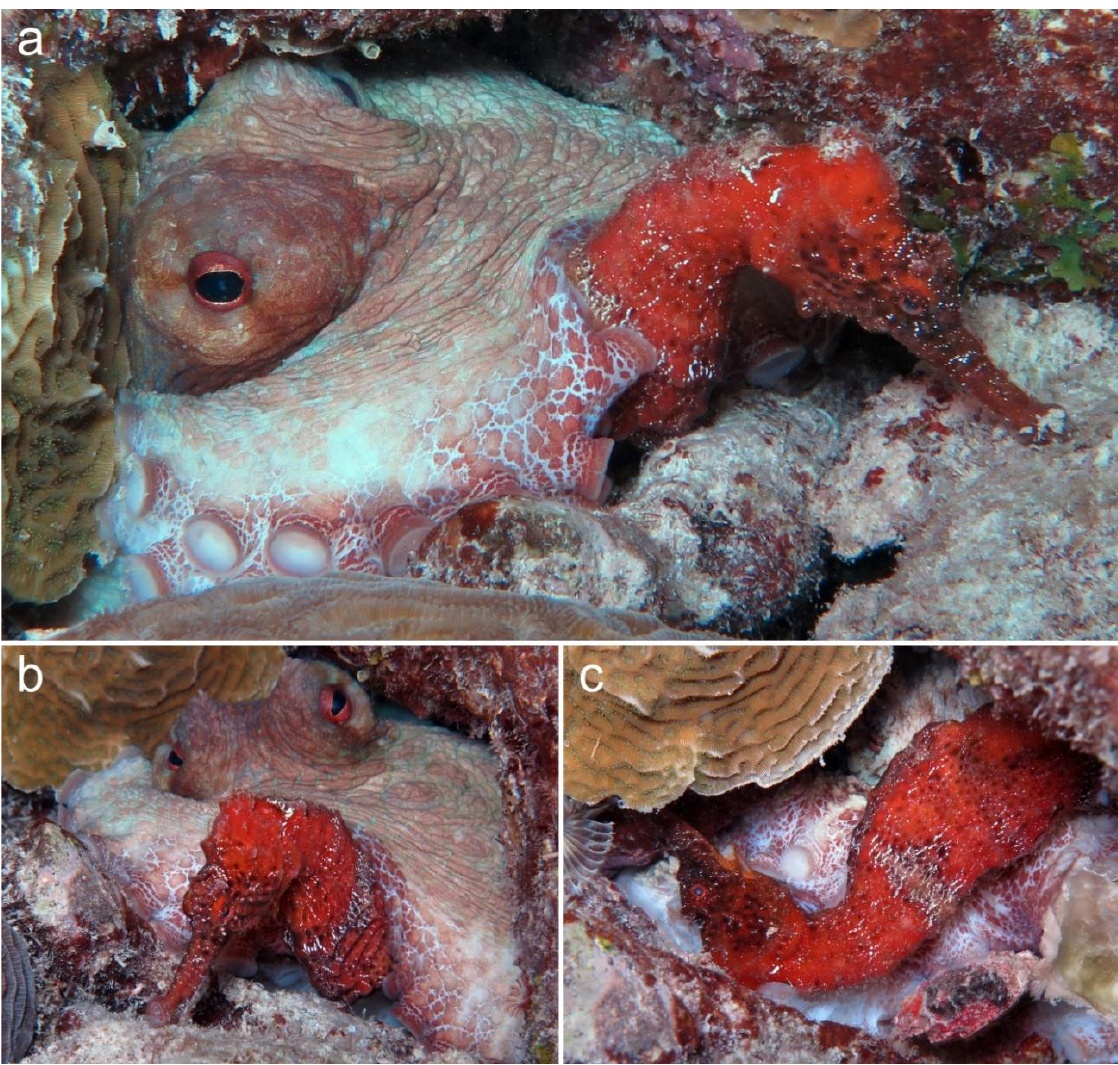
Figure 1. A red longsnout seahorse ( Hippocampus reidi ) killed by a common octopus ( Octopus vulgaris ) at Bonaire, Southern Caribbean. The octopus is partly hiding underneath a sunray lettuce coral, Helioseris cucullata. ( a,b ) The seahorse in the grip of the octopus. ( c ) The seahorse is stunned or dead. Photo credit: Ellen Muller.